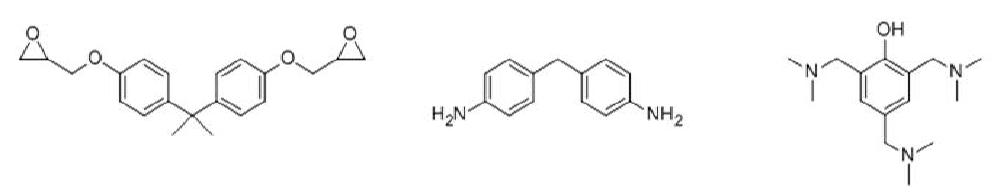
Figure 3. The chemical structure of diglycidylether of bisphenol A (DGEBA) resin ( left ), 4,4-diaminodiphenyl methane (DDM) hardener ( middle ), and tris(dimethylaminomethyl)phenol (DMP-30) accelerator ( right ).